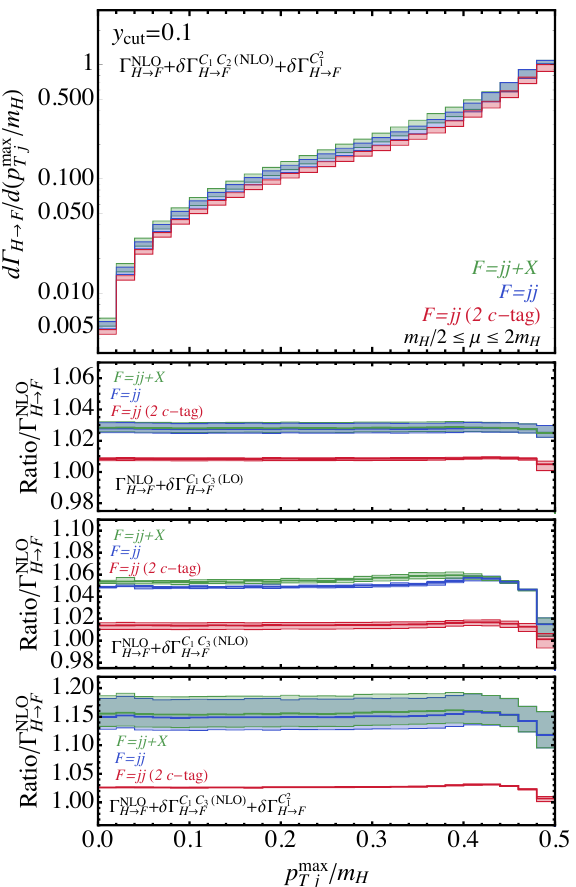
Figure 7. Differential predictions for the (fractional) transverse momentum (with respect to a fictitious collision axis ± ˆ z ) of the leading jet, clustered with y cut = 0 . 1 . Results are presented for a variety of different requirements on the final state jets, either no restrictions H → jj + X (green), requiring exactly two jets H → jj (blue) or exactly two c -tagged jets (red). The lower panels present the impact of the mixed EFT- y c piece at O ( α 2 ) , O ( α 3 ) , and the combined EFT- y c and s s EFT 2 piece at O ( α 3 ) , with respect to the NLO y 2 prediction evaluated with the same s c